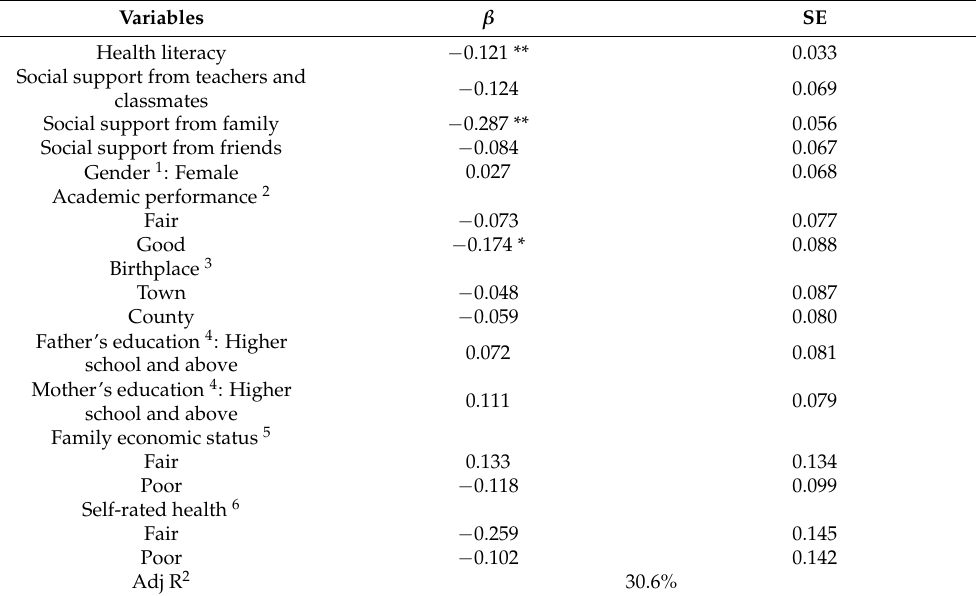
Table 3. Association between health literacy, three sources of social support and depressive